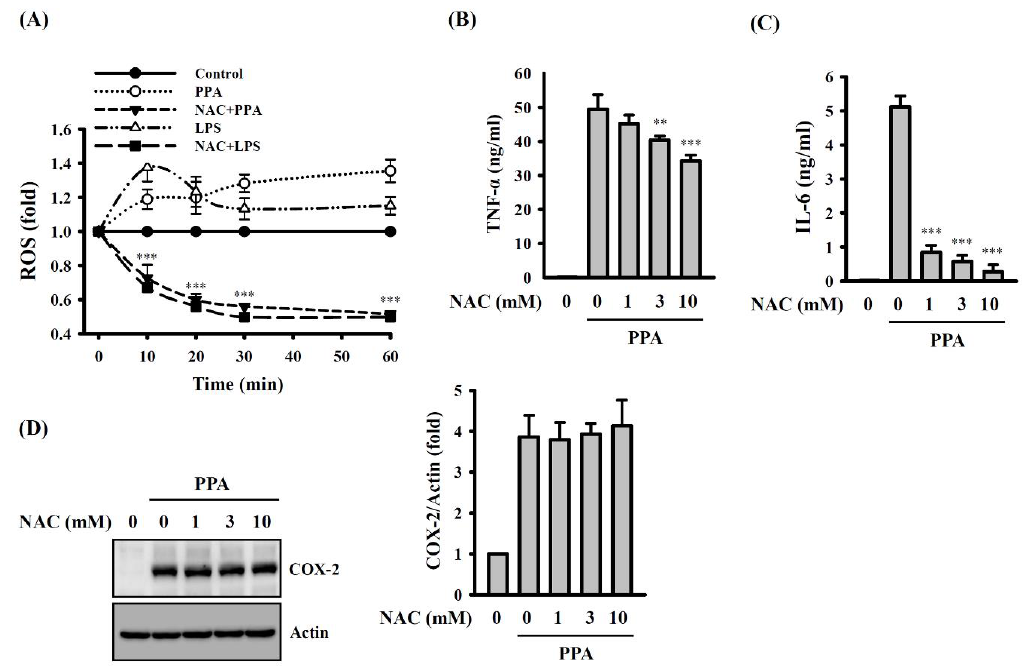
Figure 4 . PPA induces TNF- α and IL -6 secretion through ROS in RAW264.7 macrophages. ( A ) ROS production in PPA- or LPS-stimulated cells. ( B – D ) Effect of NAC on TNF- α ( B ), IL-6 ( C ) and COX-2 ( D ) in PPA-stimulated cells. ** p < 0.01 and *** p < 0.001 compared to PPA-treated cells.